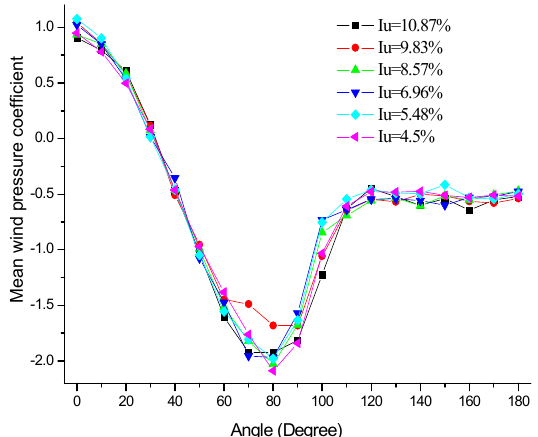
Figure 5. Mean wind pressure distributions around the cooling tower model at different turbulence intensities.